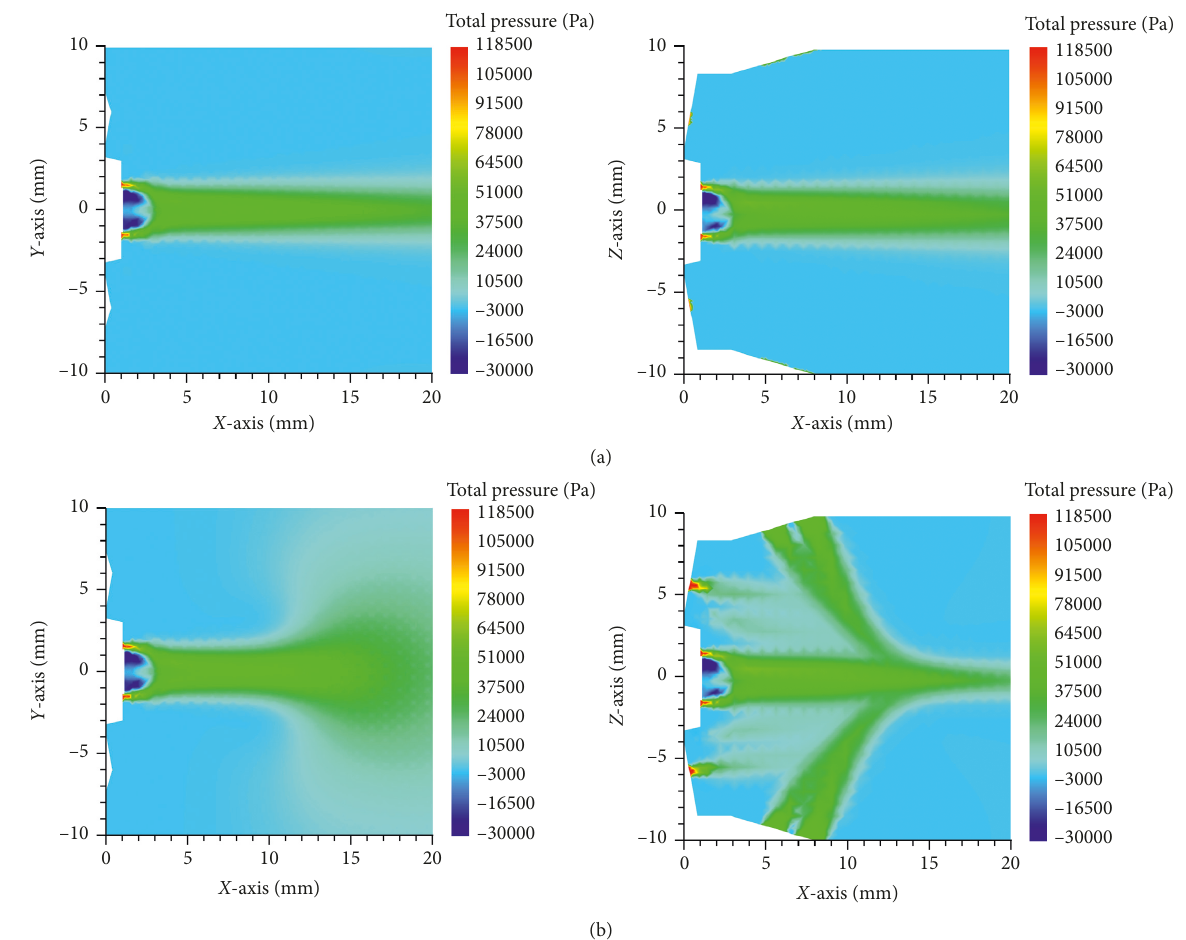
Figure 8: Comparison of spatial distribution of pressure field. (a) Pressure contours for single-hole nozzle: X - Y plane (left); X - Z plane (right). (b) Pressure contours for multiorifice nozzle: X - Y plane (left); X - Z plane